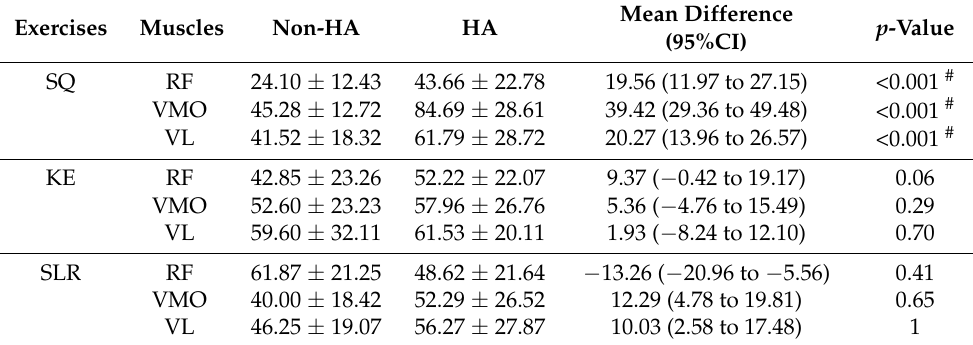
Table 1. Comparison of the RMS values of quadriceps EMG activity between exercises with and without hip